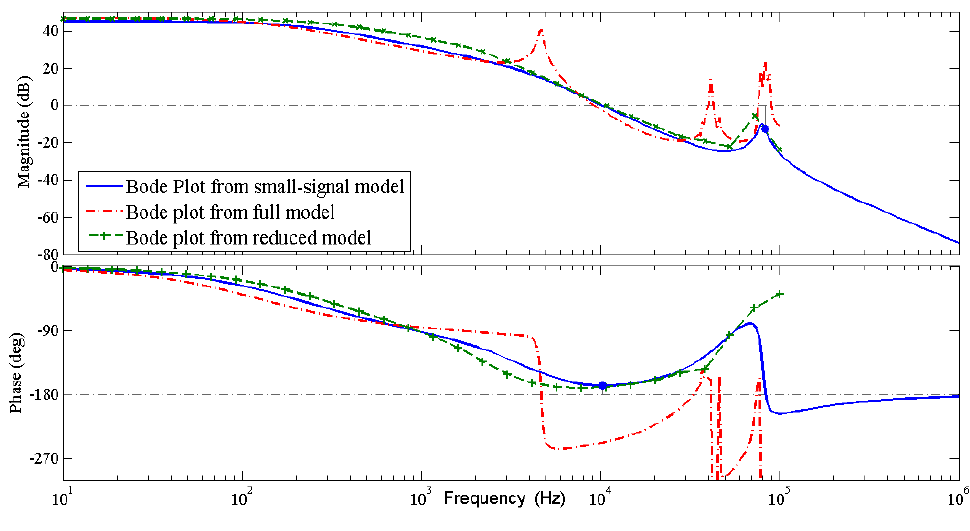
(cid:101) V 0 (cid:3023)(cid:3561) (cid:3116) for d = for d = 0.8. Figure 4. Open loop Bode plot of (cid:101) d (cid:3031)(cid:3560)